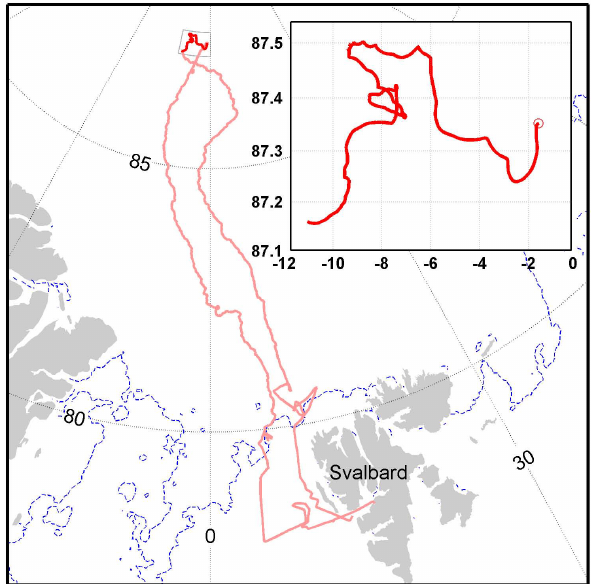
Fig. 1. Oden icebreaker track (pink) with the ice-drift path enlarged in the insert marked red. The circle indicates the start of the ice- drift. The observed ice edge on 12 August 2008 is given by the thin blue line.